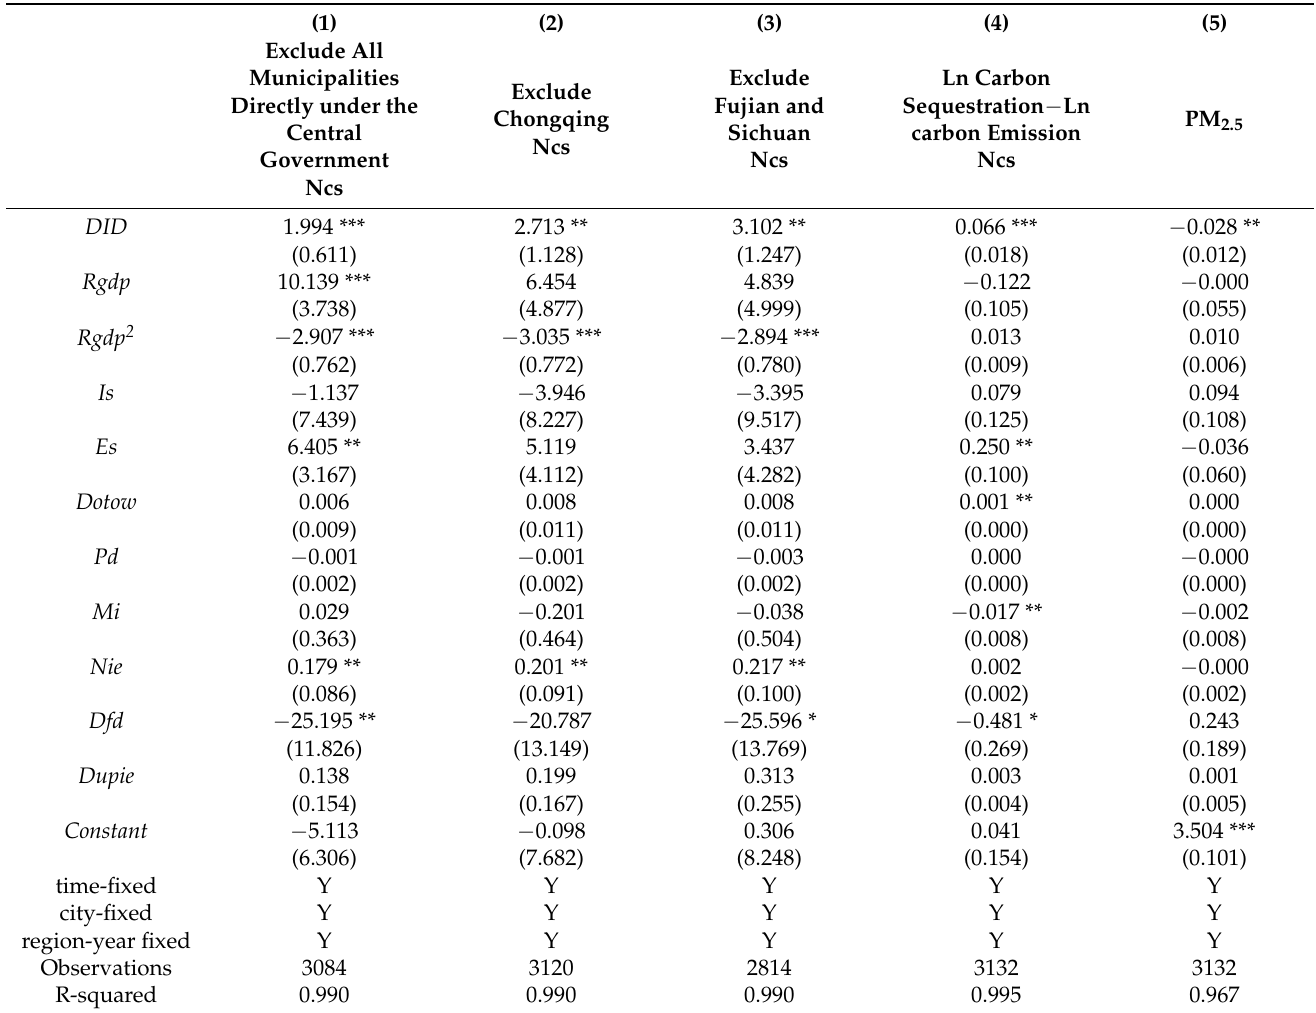
Table 5. Other robustness tests: excluding the effect of special samples and replacing the depen- dent